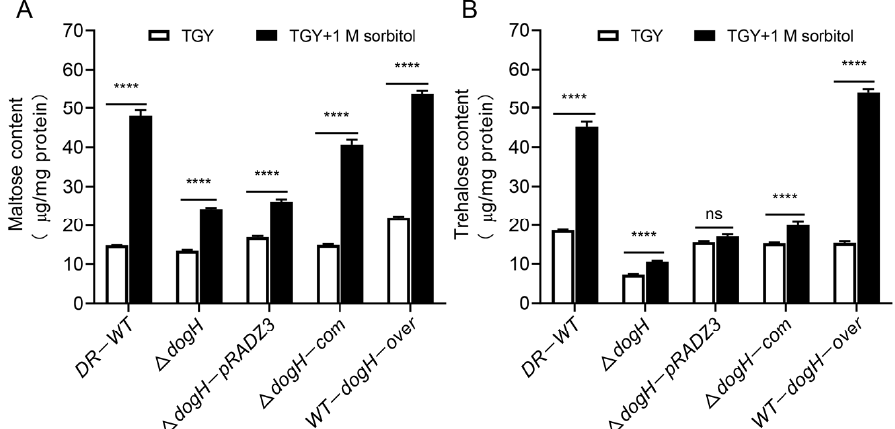
Figure 6. Determination of osmoprotectant content in different D. radiodurans strains by HPLC-MS. ( A ) Maltose content. ( B ) Trehalose content. DR-WT: wild-type strain; ∆ dogH : dogH -deleted mutant; ∆ dogH -pRADZ3: dogH mutant transformed with pRADZ3 empty plasmid; ∆ dogH -com: dogH mutant supplemented with the dogH gene. WT- dogH -over: wild-type overexpression with the dogH gene. 1.0 M sorbitol stress treatment for 3 h treated (black bars) and nontreated (white bars). One-way ANOVA and Dunnett’s multiple-comparison test; A probability value of p ≤ 0.05 was considered significant. Data are presented as averages ± SEM. ****: p ≤ 0.0001; and ns: non − signi fi cant.